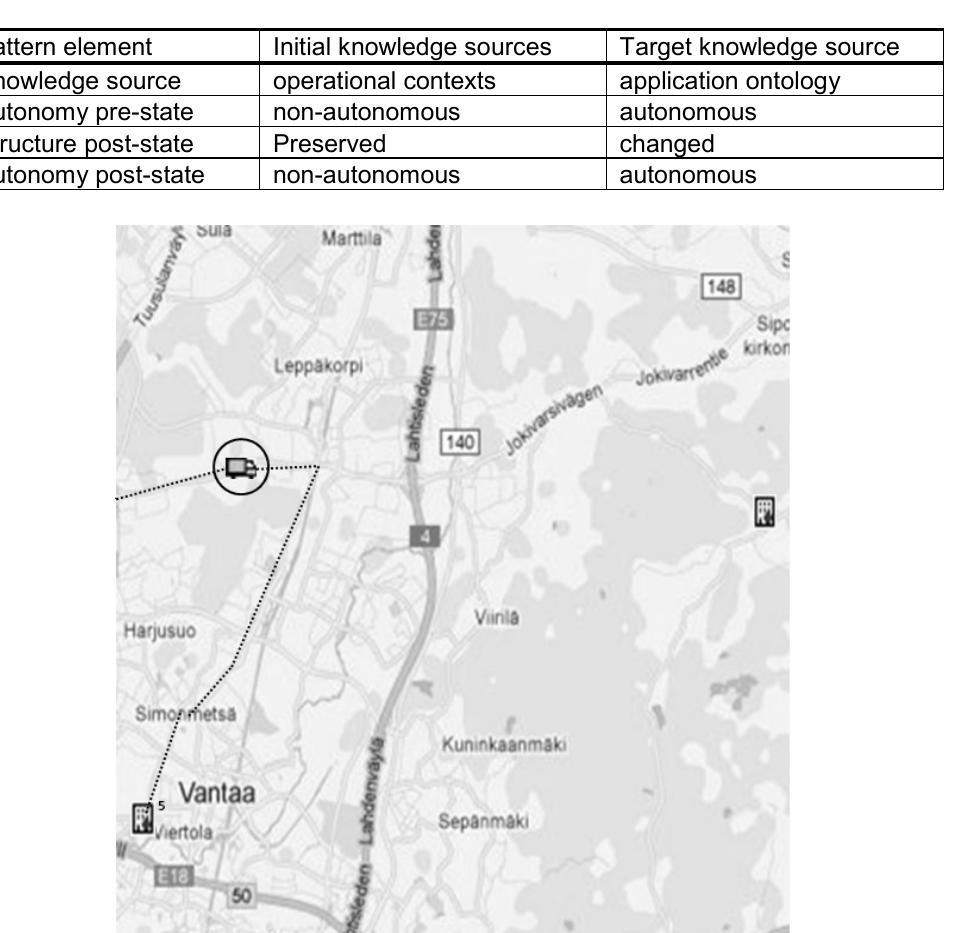
Figure 5. History for an emergency